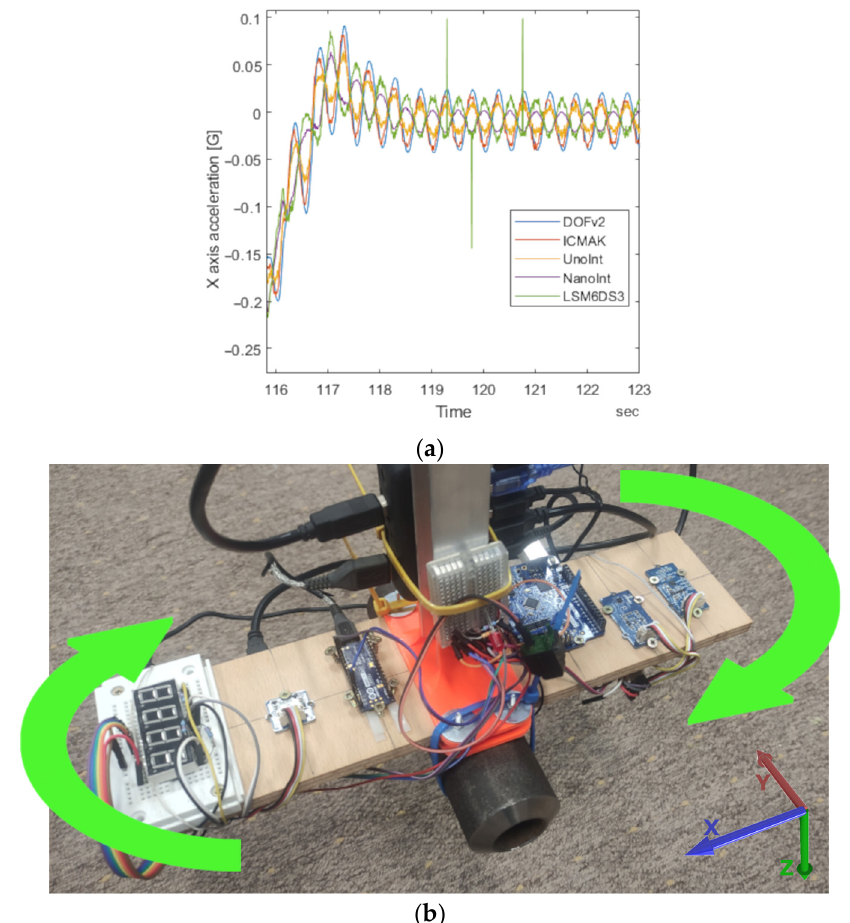
Figure 15. ( a ) Out-of-phase acceleration on the x-axis in the period of harmonic axial rotation. ( b ) The direction of the axes in laboratory setup and the torsional forces exerted on the wooden platform that carries the sensors.